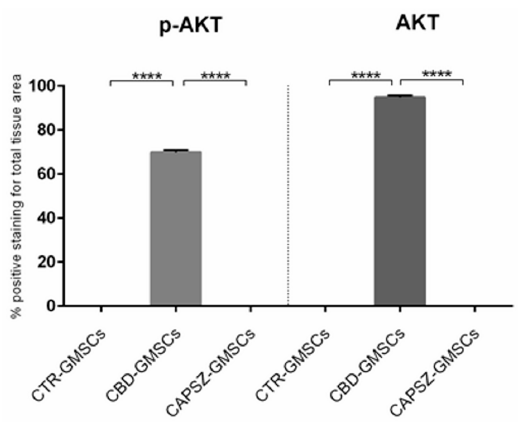
Figure 5. Immunostaining for p-Akt and Akt. CBD-GMSCs showed positive staining for p-Akt and Akt, whereas CTR-GMSCs and showed negative expression for these proteins. The expression of Akt and p-Akt was abolished by pre-treatment of GMSCs with Capsazepine/TRPV1 antagonist (CAPSZ-GMSCs); CTR-GMSCs vs. CBD-GMSCs **** p < 0.0001; CBD-GMSCs vs. CAPSZ-GMSCs **** p < 0.0001. Densitometric analysis was carried out on 3/6 coverslips by covering about 90% of the total area for each experimental group. Objective: 40×, bar length: 50 μ m.